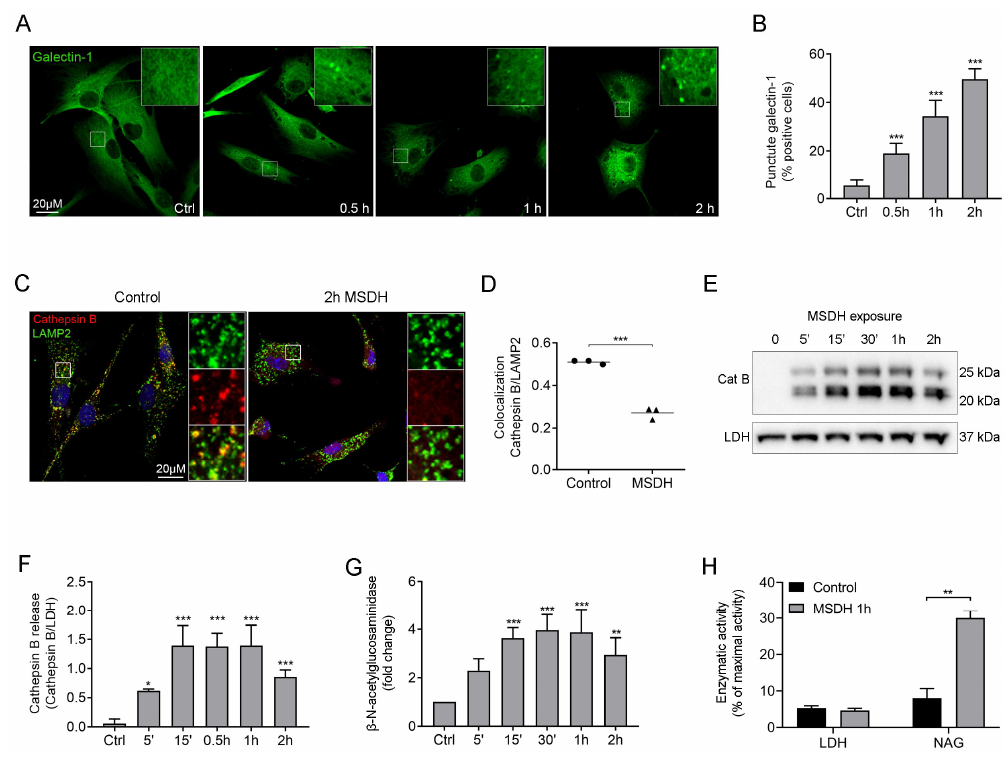
Figure 5. Lysosomal membrane permeabilization in response to MSDH treatment. Human fibroblasts were exposed to MSDH for 5 min–2 h. ( A ) Lysosomal rupture detected by Galectin-1 staining (green) in cells exposed to 15 µ M MSDH, with ( B ) corresponding image analysis of Galectin-1 puncta-positive cells. ( C ) Immunostaining of cathepsin B (red), lysosomal-associated membrane protein-2 (LAMP2) (green) and nuclei (DAPI; blue) in cells exposed to MSDH (15 µ M, 2 h). Merged image shows colocalization between cathepsin B and LAMP2 in yellow. ( D ) The estimated colocalization was obtained from image analysis in C. ( E ) Lysotracker staining of live cells before and after MSDH exposure (15 µ M, 10 min). ( F ) Immunoblotting of active cathepsin B and lactate dehydrogenase (LDH) in cytosolic fractions from cells exposed to 15 µ M MSDH, with corresponding densitometric analysis of cathepsin B release, correlated to LDH. ( G ) β -N-acetyl-glucoseaminidase (NAG) activity in cytosolic fractions. ( H ) Release of LDH and NAG to cytosol in cells exposed to 15 µ M MSDH. The results are shown as mean ± SD ( n = 3), * p < 0.05, ** p < 0.01 and *** p < 0.001 compared to untreated control.